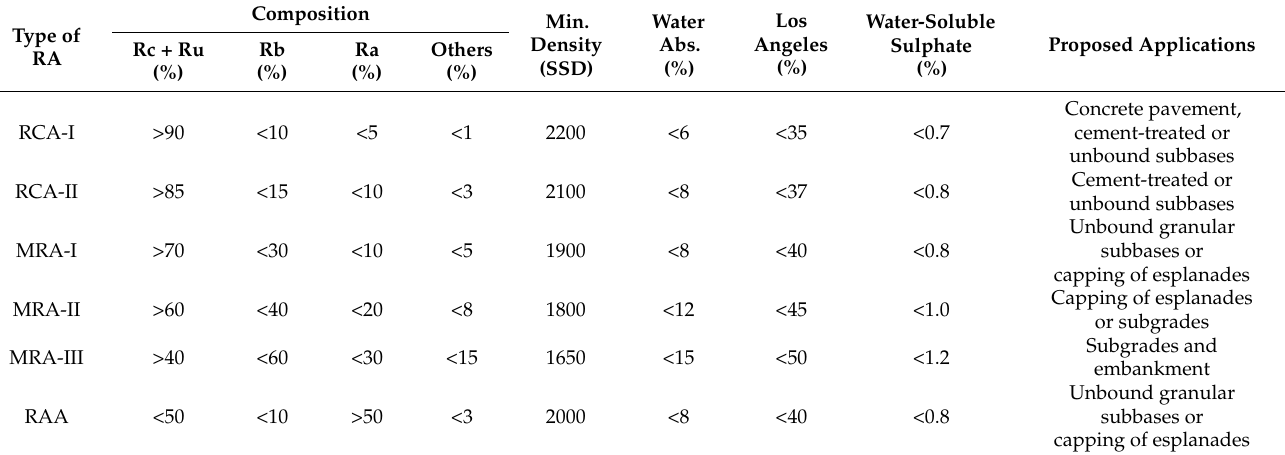
Table 2. Classification of RAs for international application in road sections [81].